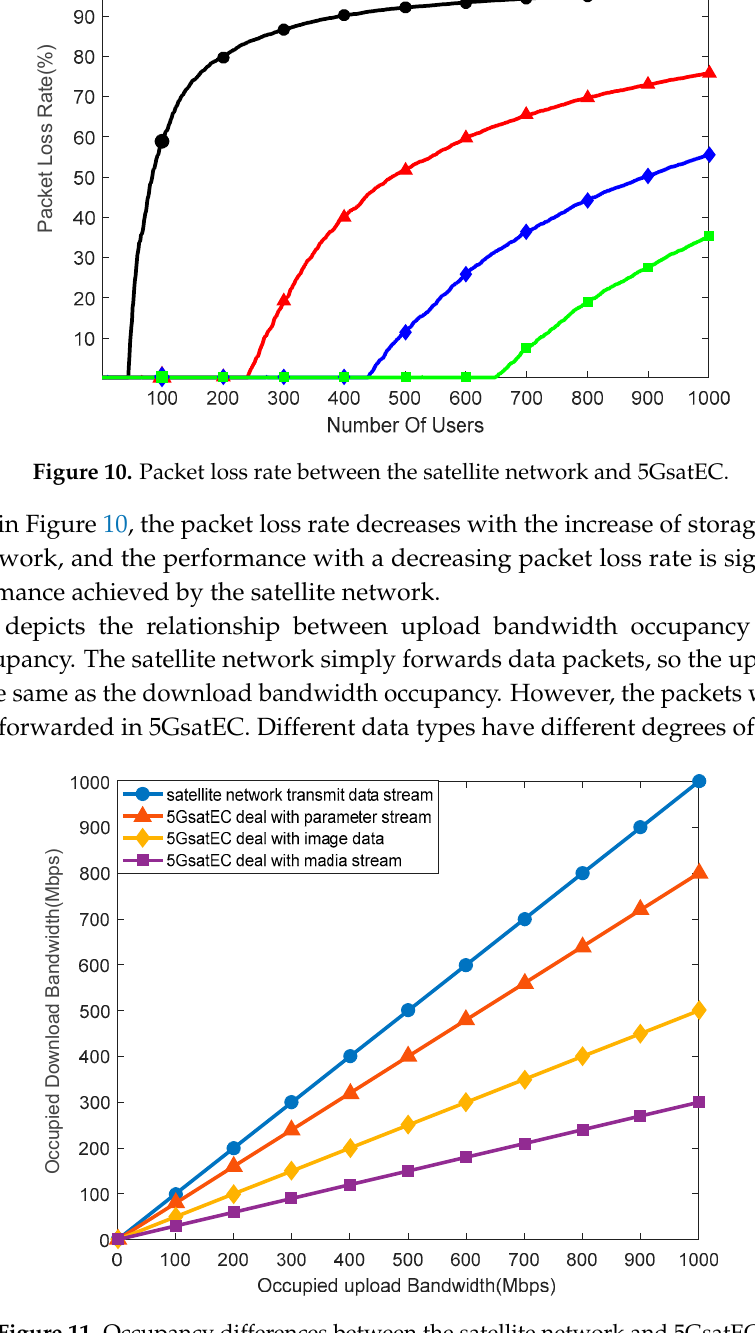
Figure 11. Occupancy differences between the satellite network and 5GsatEC.